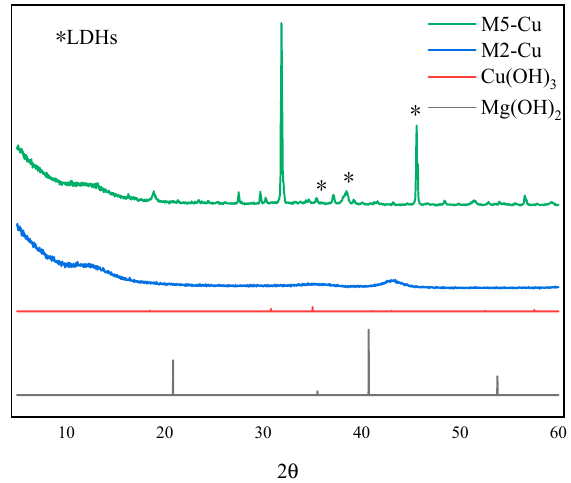
Figure 8. X-ray diffraction results for some Zn-doped MMH samples.